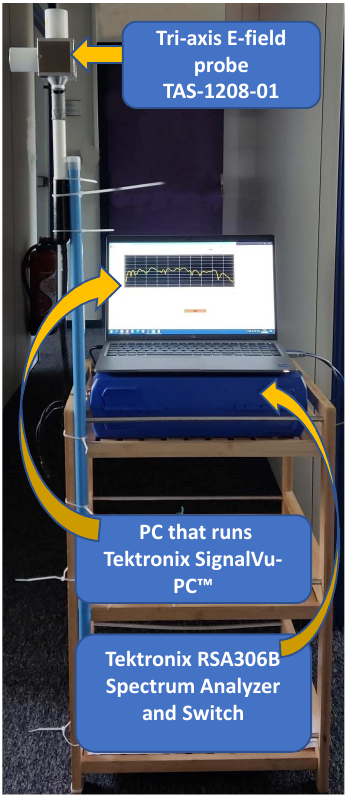
Figure 1. Real-time spectrum analyzer EMF measurement